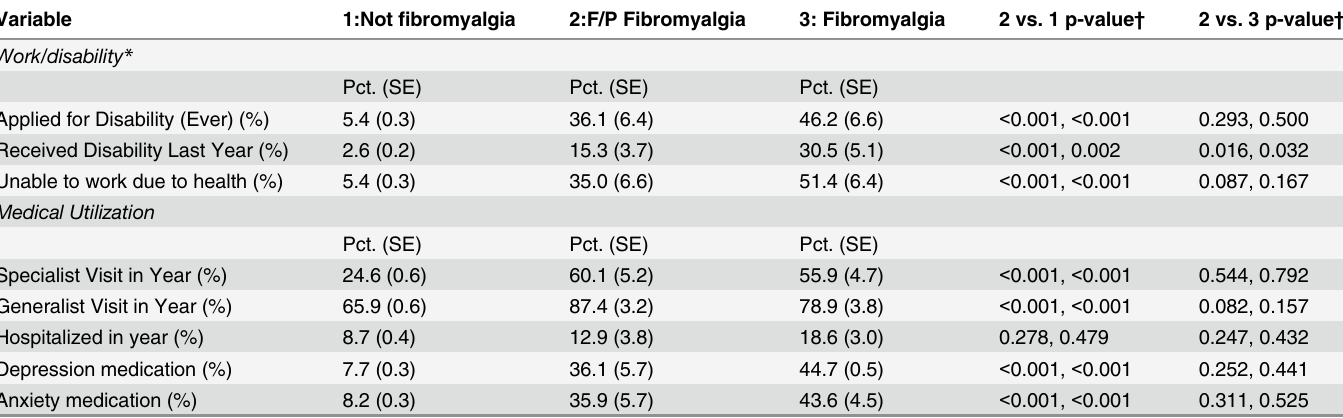
Table 3. Comparison of selected work and health utilization between persons without fibromyalgia, FP fibromyalgia, and those that meet NHIS fibromyalgia criteria.